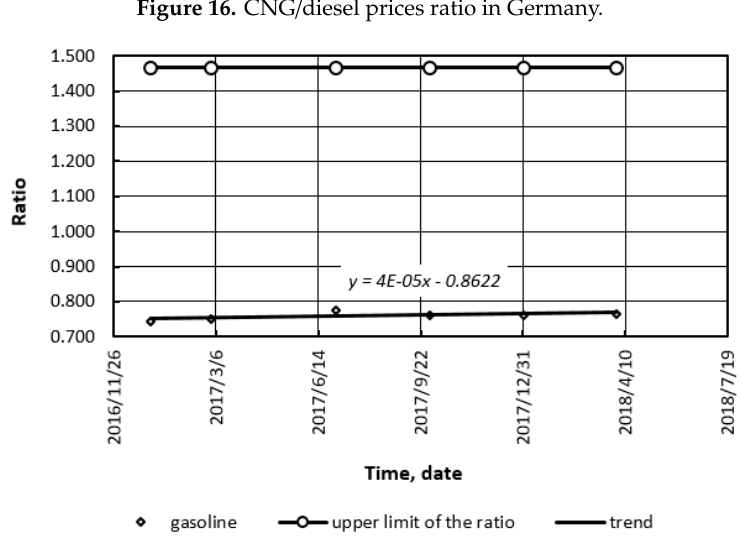
Figure 17. CNG / diesel prices ratio in Figure 17. CNG/diesel prices ratio in Germany. Figure 17. CNG/diesel prices ratio in Germany.